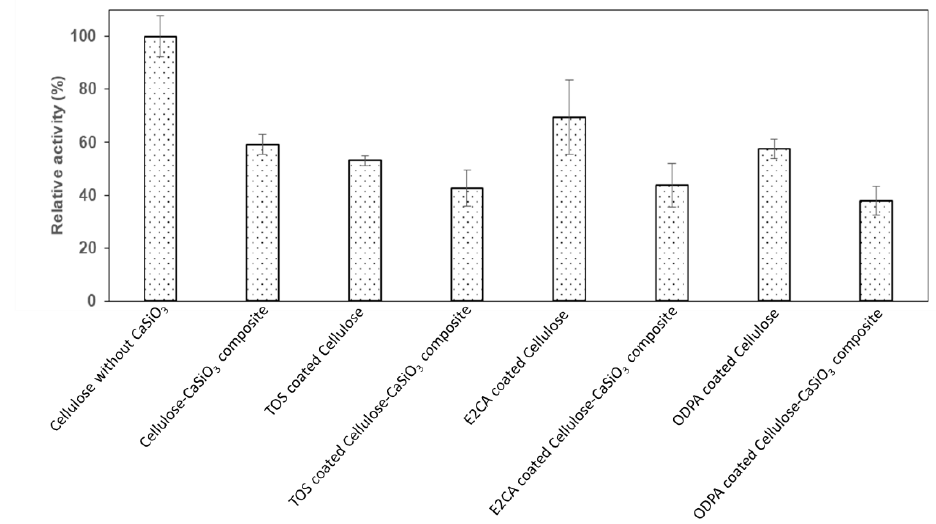
Figure 8. Cellulase activity with different cellulose-based composites as substrates.